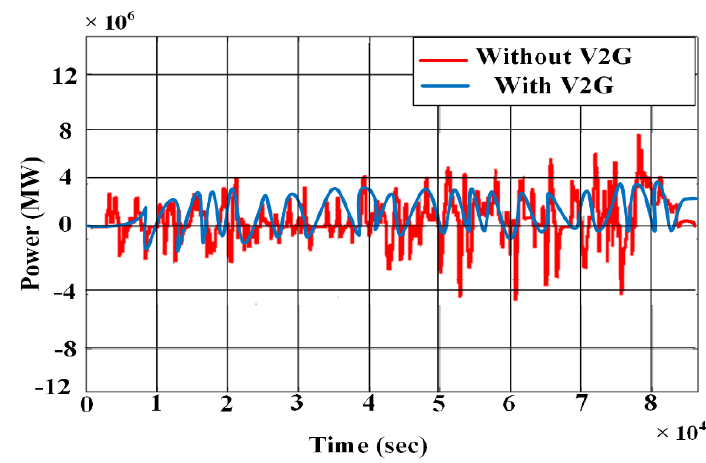
Figure 15. Results of ACE and the pre-and-post V2G strategy application.